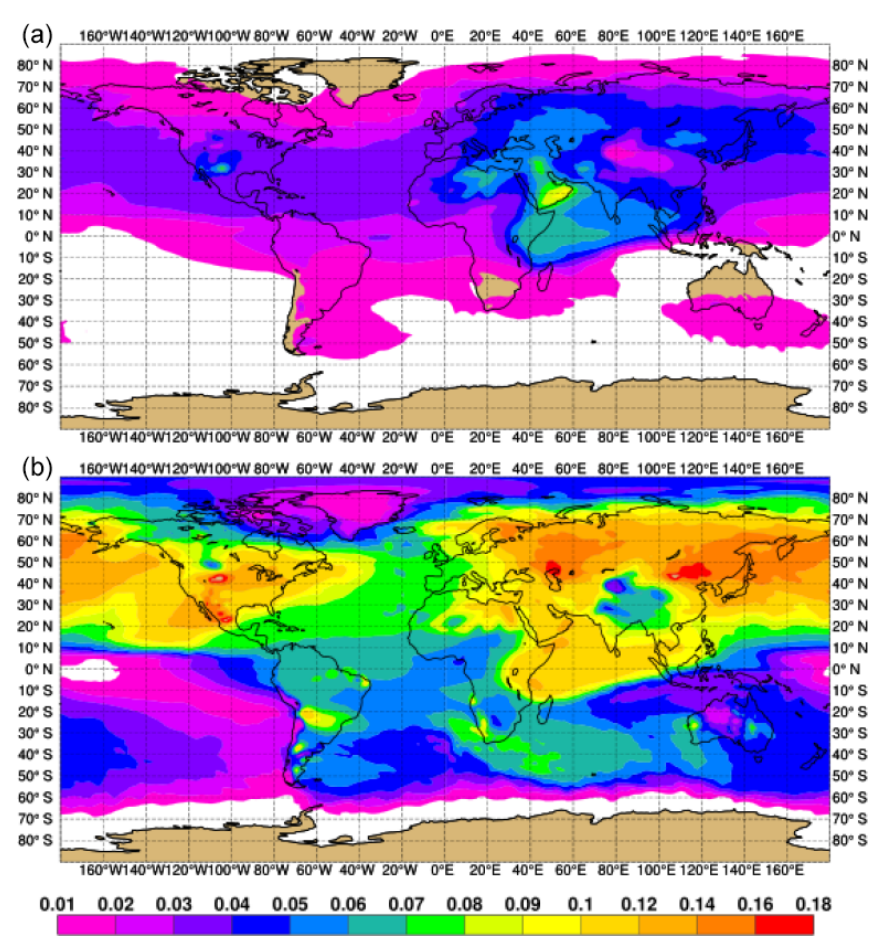
Figure 6. Average fraction of calcite over super-coarse (a) and coarse (b)